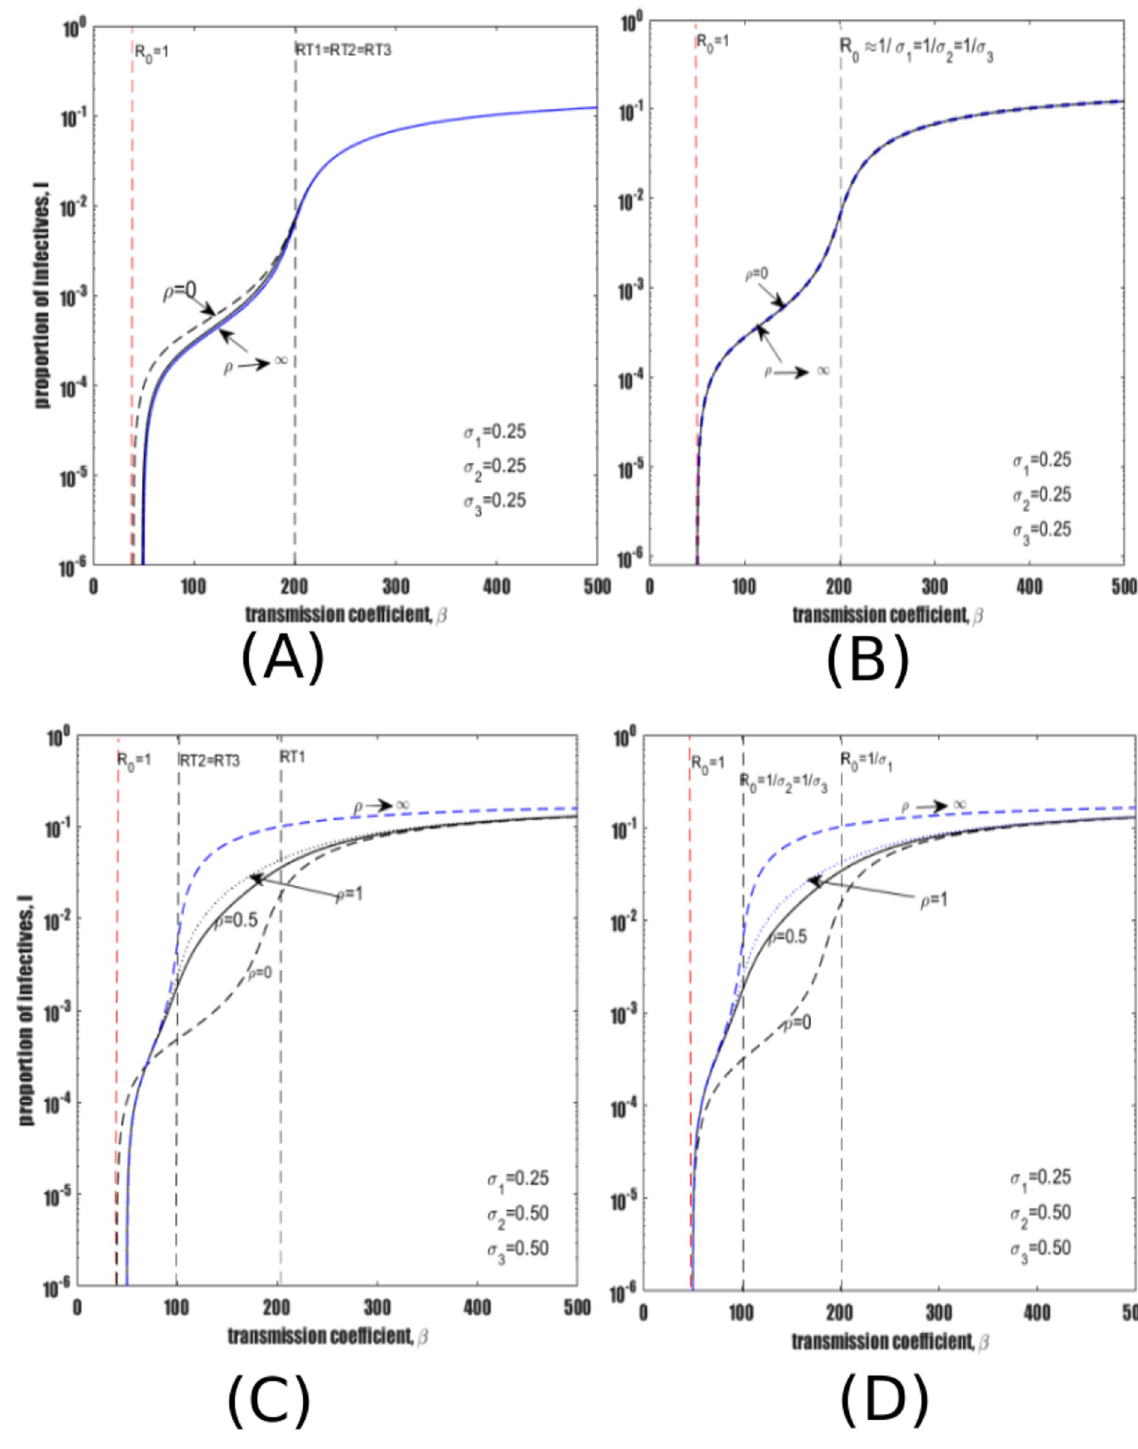
Fig 8. Treatment of late latent infection under the assumption of no effect on susceptibility to reinfection (panels (A) and (B)) and increased susceptibility (panels (C) and (D)), with reactivation mechanisms present (panels (A) and (B)) and removed (panels (B) and (D)). Parameters used are τ = 2, θ = 1, ρ = 0, 0.5, 1 and ρ ! 1 while other parameters remain as in Table 1. The risks of reinfection used are shown in each figure.